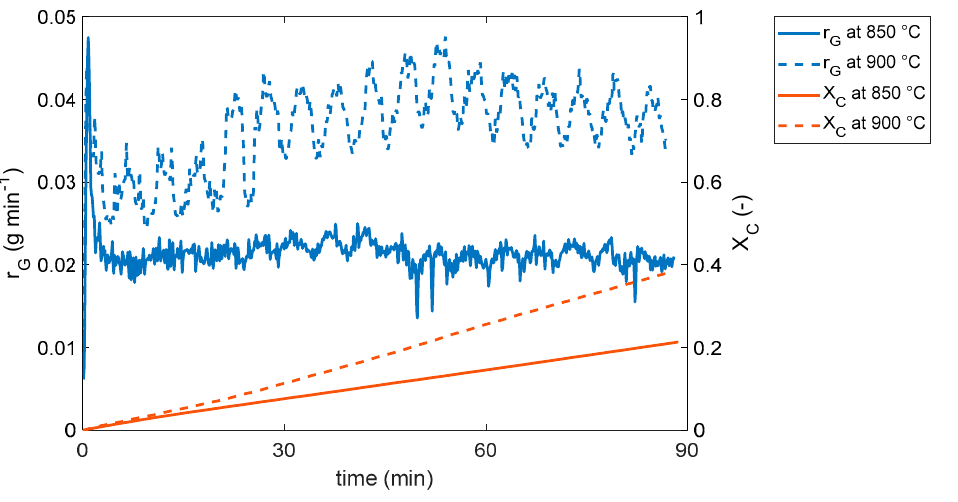
Figure 3. Comparison of calculated r G and Xc during 90 min tar reforming over PSC.